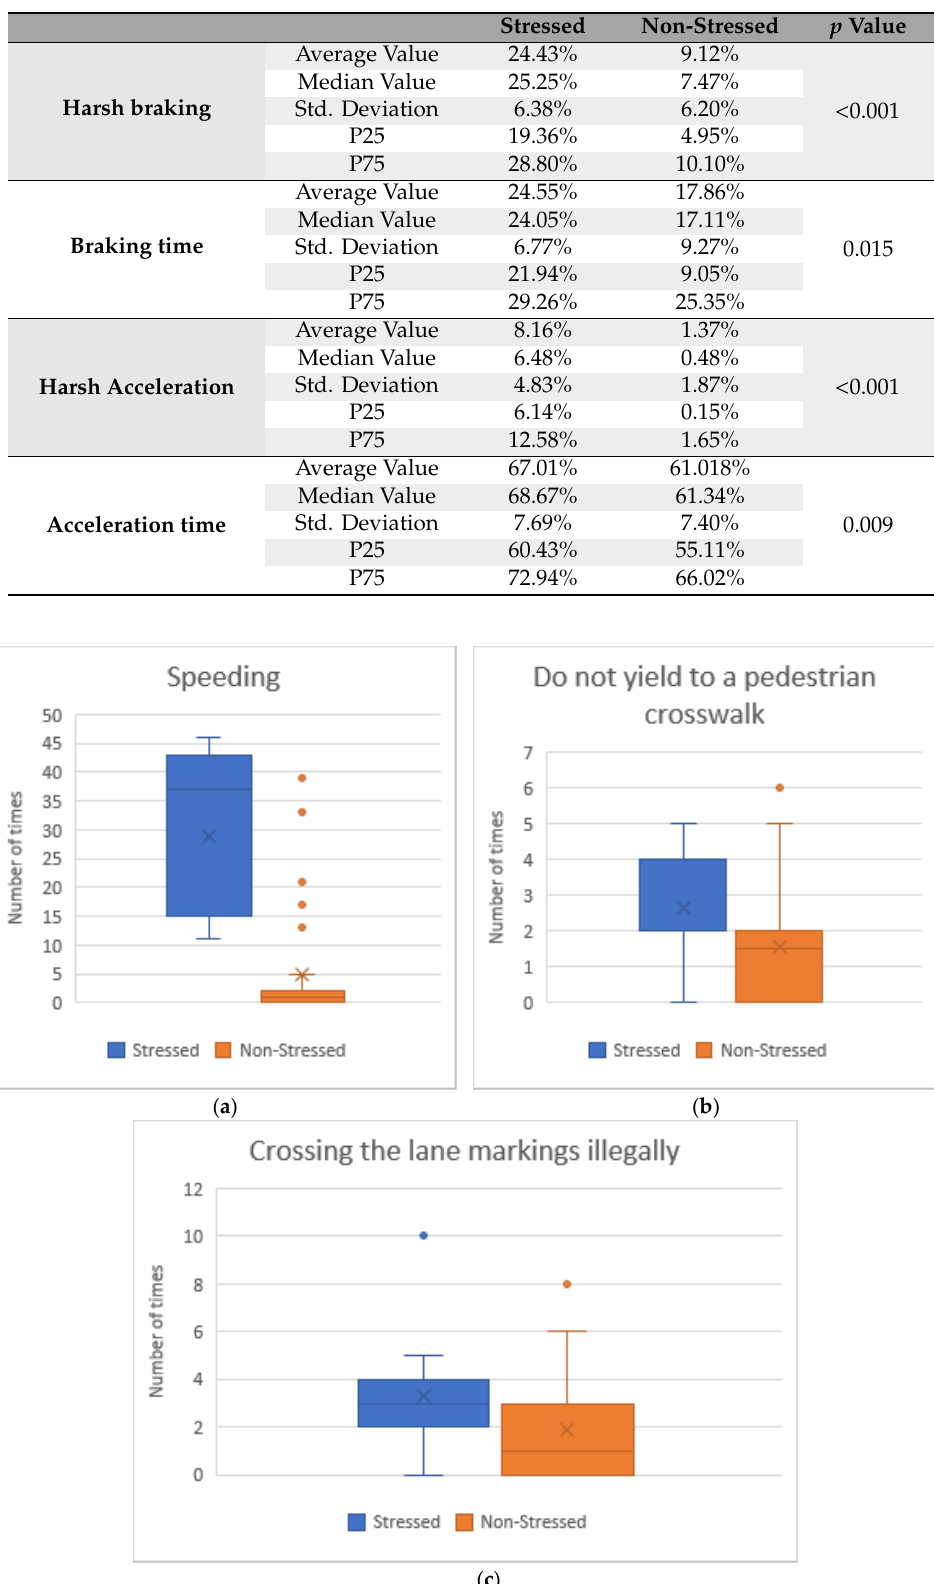
Table 7. Driving behavior grouped by initial stress level.